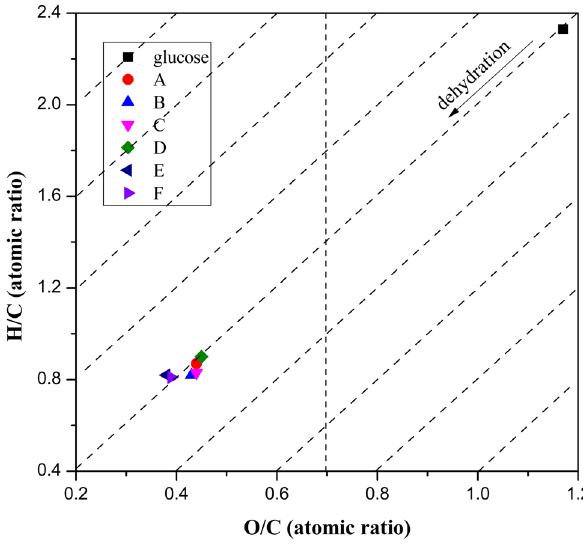
Figure 1: Van Krevelen diagram of glucose and carbon microspheres